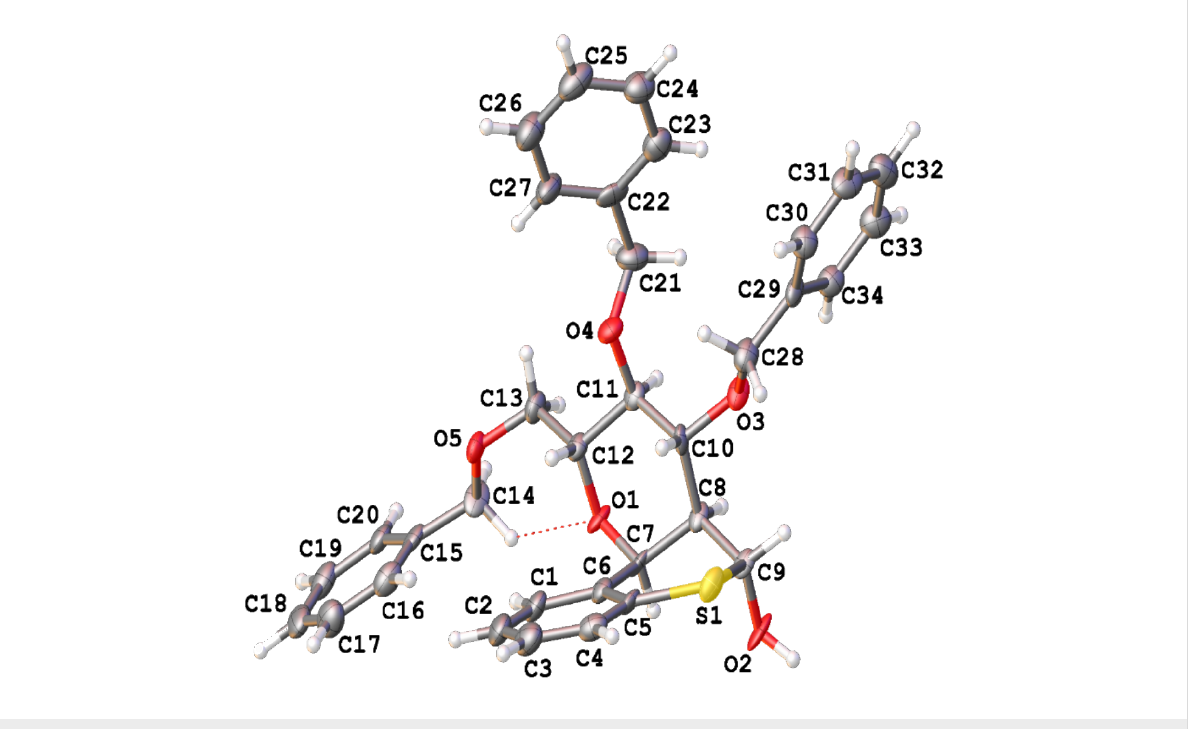
Figure 1: Single X-ray crystal structure of hemithioacetal 3a